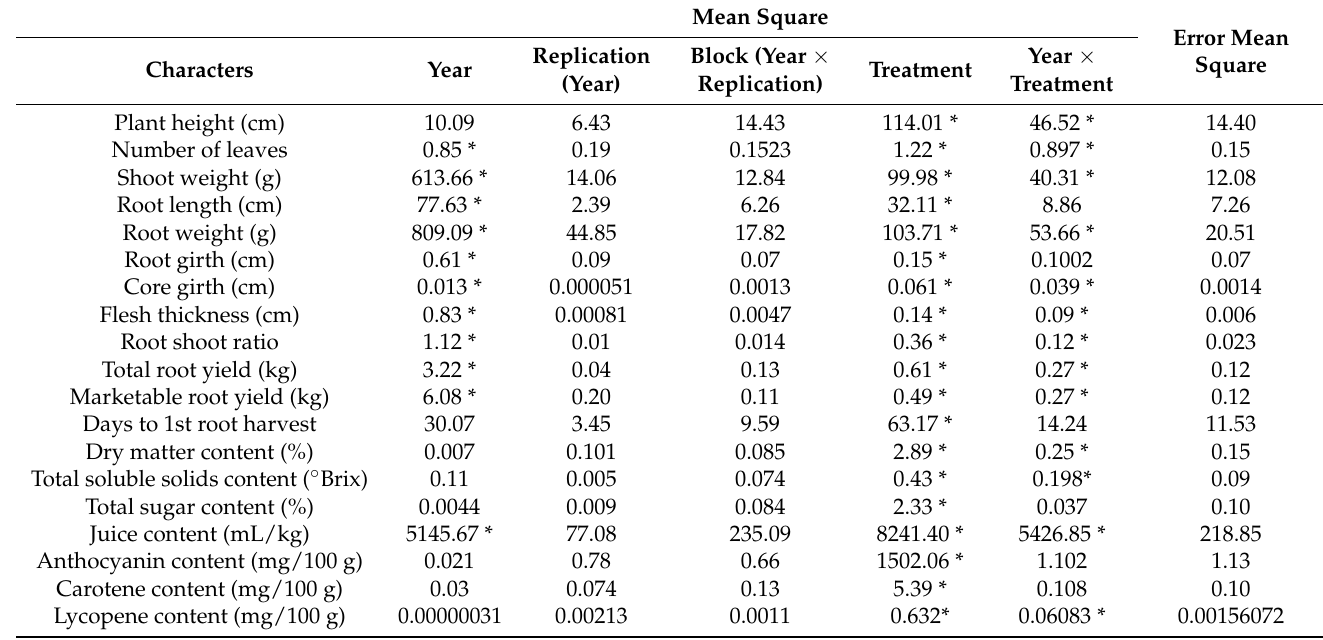
Table 1. Analysis of Variance (ANOVA) for different traits of carrot